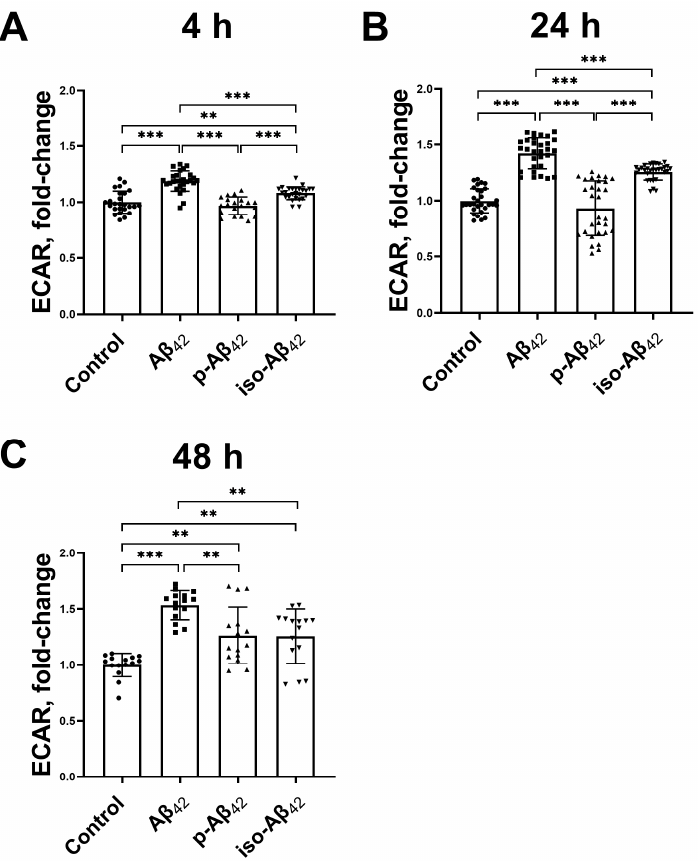
Figure 9. Effect of beta-amyloid isoforms on the extracellular acidification rate. Mouse brain en- dothelial cells bEnd.3 were incubated for ( A ) 4 h, ( B ) 24 h and ( C ) 48 h with 10 µ M of A β 42 , p-A β 42 and iso-A β 42 . Extracellular acidification rate (ECAR)—the level of acidification of the extracellular medium. The values in the control samples were taken as 1. The histograms indicate the ratio of values in samples with beta-amyloid isoforms, normalized to the control. Each geometric figure (circle/square/up-pointing triangle/down-pointing triangle) in the histogram represents the result in an independent sample and corresponds to the Control, A β 42 , p-A β 42 and iso-A β 42 . The mean ±